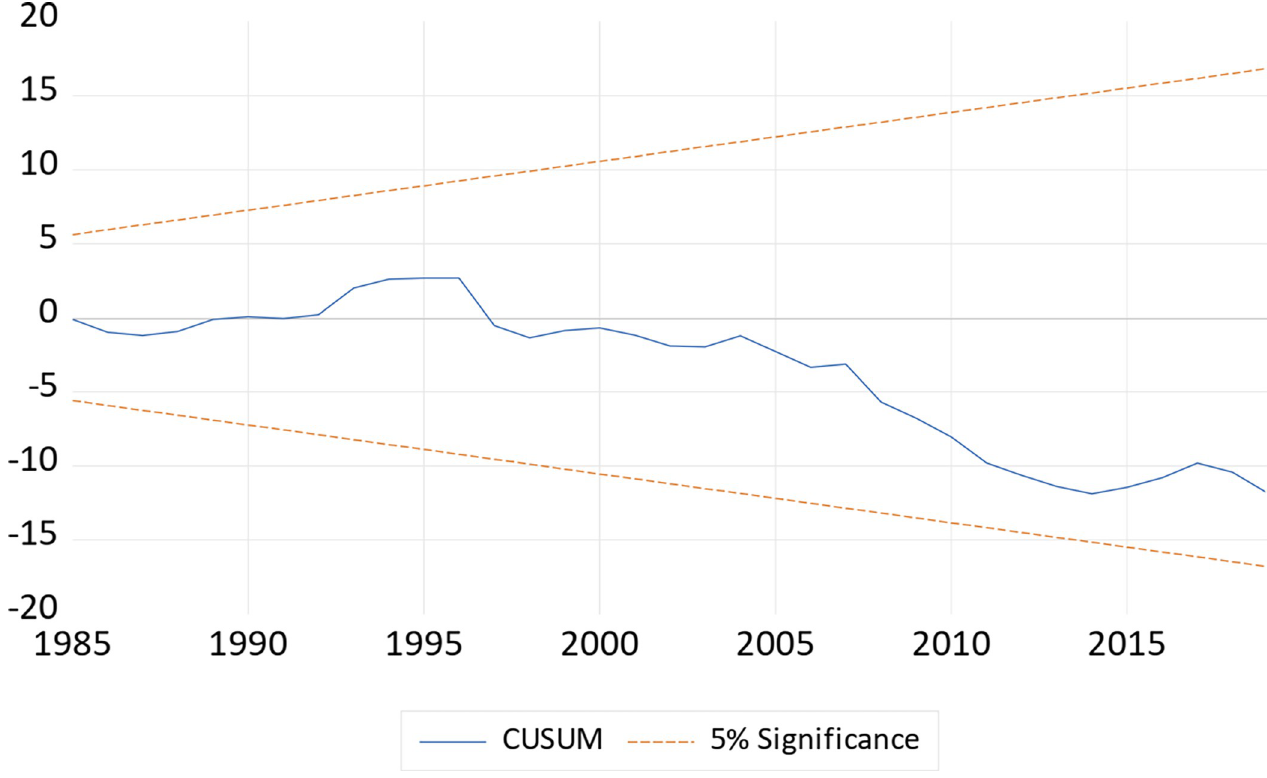
Fig 1. Plot of cumulative sum of recursive